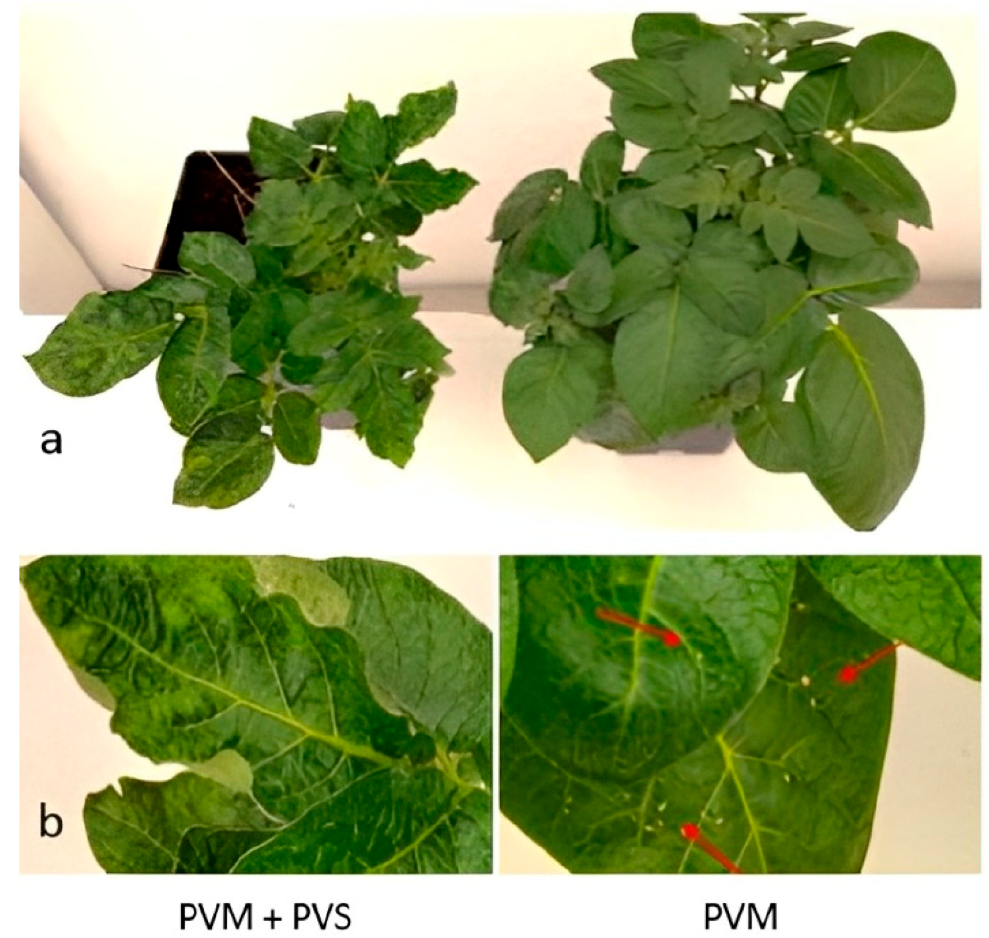
Figure 3. Symptoms in mixed infection with PVM + PVS compared to a plant infected only with PVM; view on the whole plant ( a ) and details on the leaf ( b ). Arrows show small